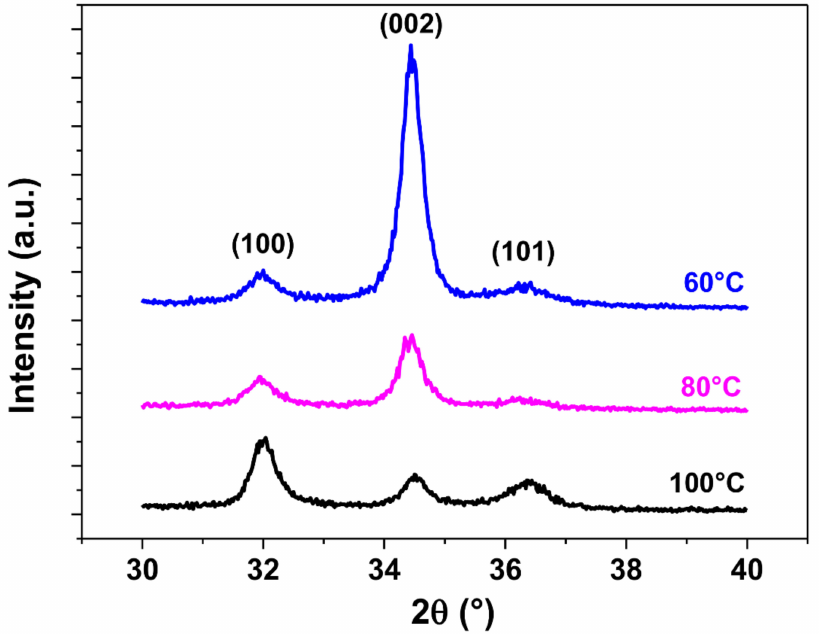
Figure 7. GI-XRD diffraction patterns ( ω = 0.3 ◦ ) of ZnO thin films grown on Si substrates coated with a 200 nm thick Pt layer at 100 ◦ C, 80 ◦ C and 60 ◦ C.